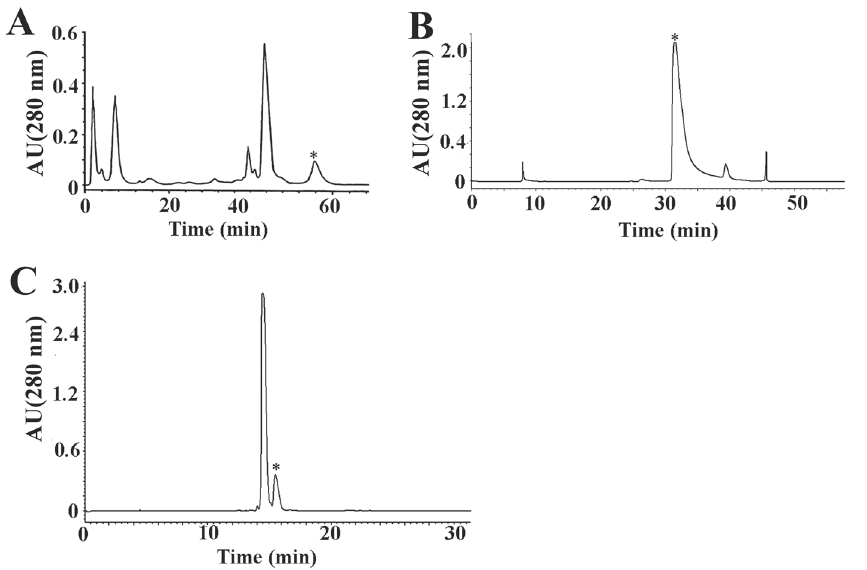
Figure 1. HPLC purification of mHWTX-IV. The peaks marked by * contain mHWTX-IV. (A) Elution profile of Ornithoctonus huwena Wang venom by ion-exchange HPLC. (B) Isolation of mHWTX-IV by RP-HPLC on a C18 column in a gradient of 10–50% acetonitrile over 50 min. (C) Further purification of mHWTX-IV by a repetitive RP-HPLC with a gradient of 28–40% acetonitrile over 30 min.